Question: What does this figure show? Answer in one sentence.
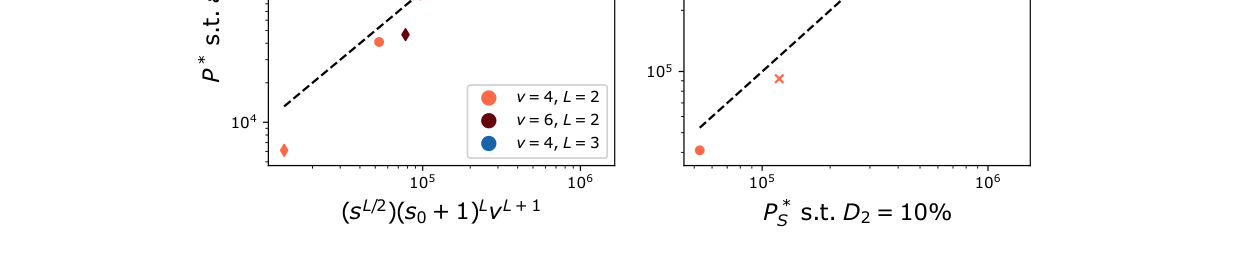
Answer: LCN. Left panel: empirical sample complexity P ∗to reach a 10% test error ε versus empirical sample complexity P ∗ S to reach S2 = 50% (as defined in Eq. 6) for s = 3, different vocabulary sizes v and different depths L (different colors), number of classes nc = v, maximal m = vs−1 and different s0 (different markers). Right panel: same as left for the sample complexity P ∗ D to reach a D2 = 10% (with D2 as defined in Eq. 7). The thresholds have been tuned based on the form of S2 and D2 versus P.